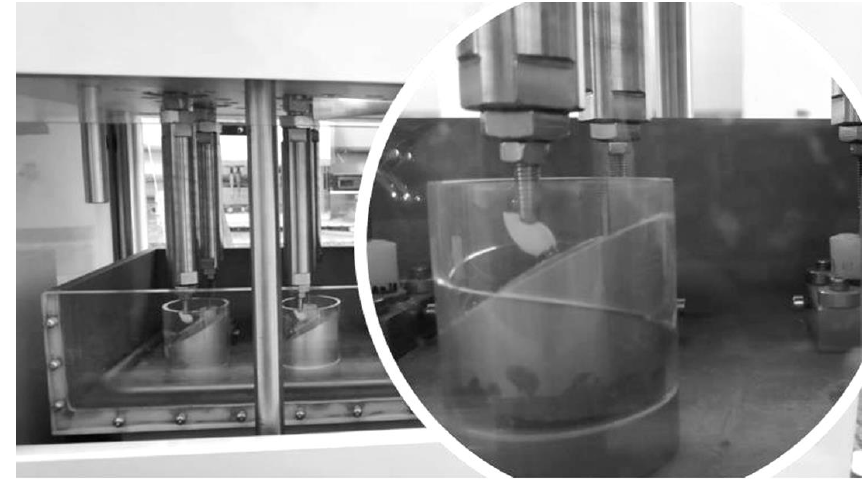
Figure 5. Illustration of the base at 30° to the ground during stepwise fatigue.